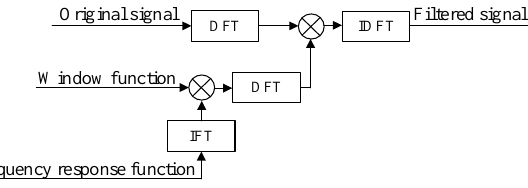
Figure 8. The finite impulse response (FIR) filtering algorithm flow chart.